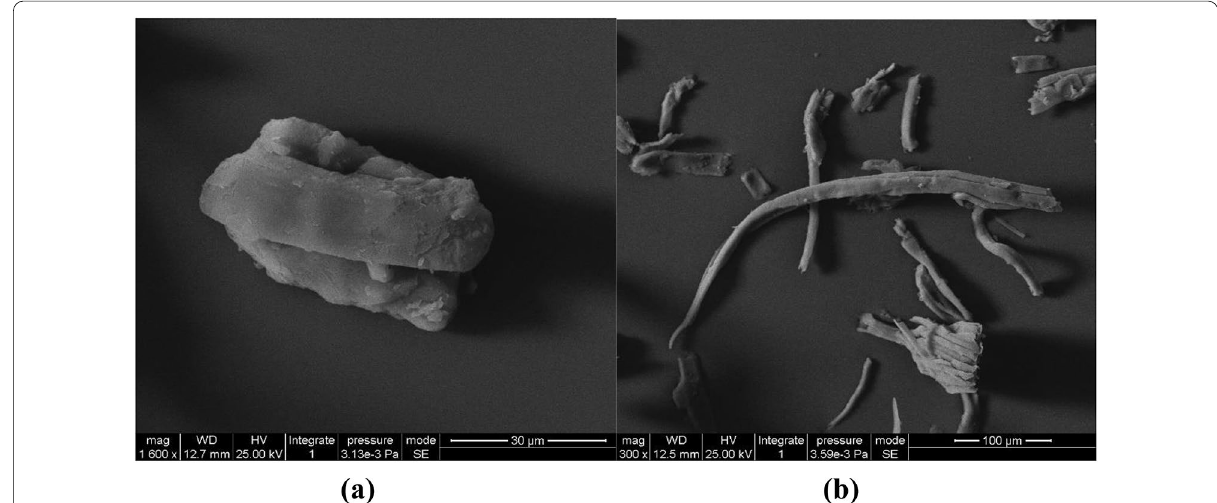
Fig. 12 The SEM images of dust particles. a The most typical particle with d eq